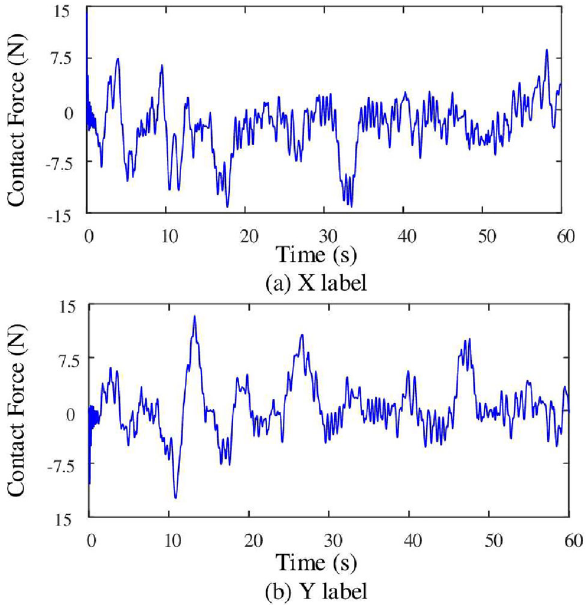
Fig. 17 Human–robot interaction contact force curves under existing integral sliding mode control method